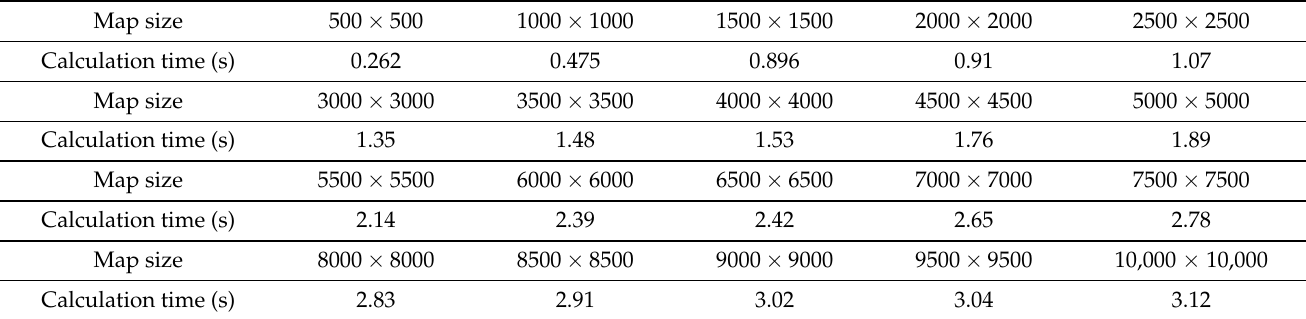
Table 5. Comparison of computational efficiency.